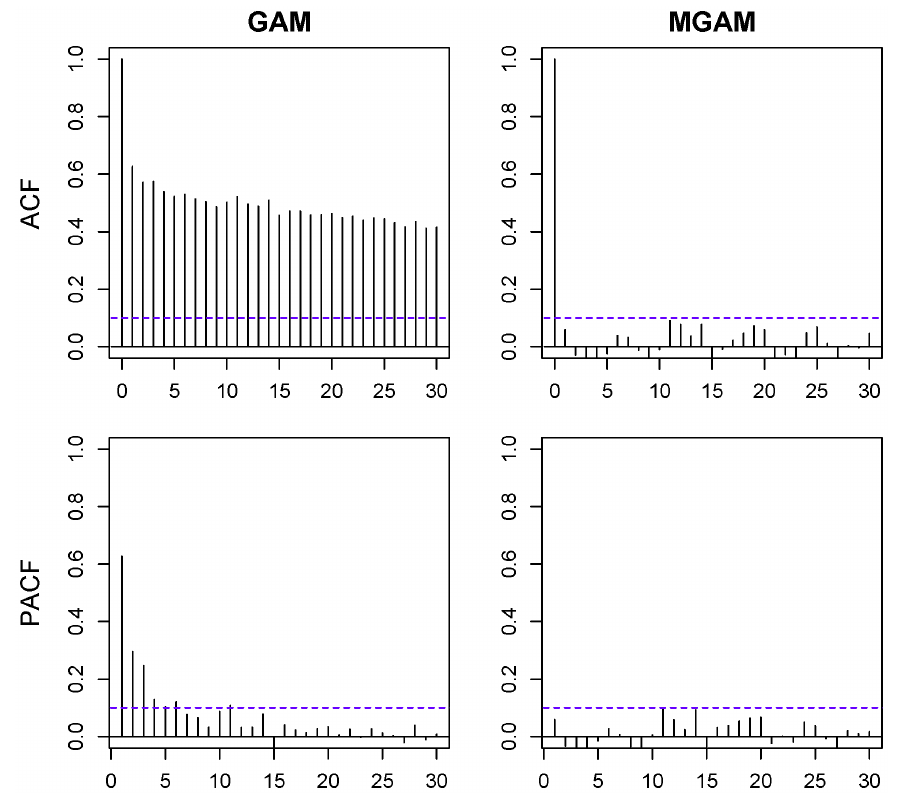
Figure 5. Residual autocorrelation and partial autocorrelation of GAM and MGAM with df t =6. Upper left is the autocorrelation function (ACF) of GAM residuals. Upper right is the ACF of MGAM residuals. Lower left is the partial autocorrelation function (PACF) of GAM residuals. Lower right is the PACF of MGAM residuals.